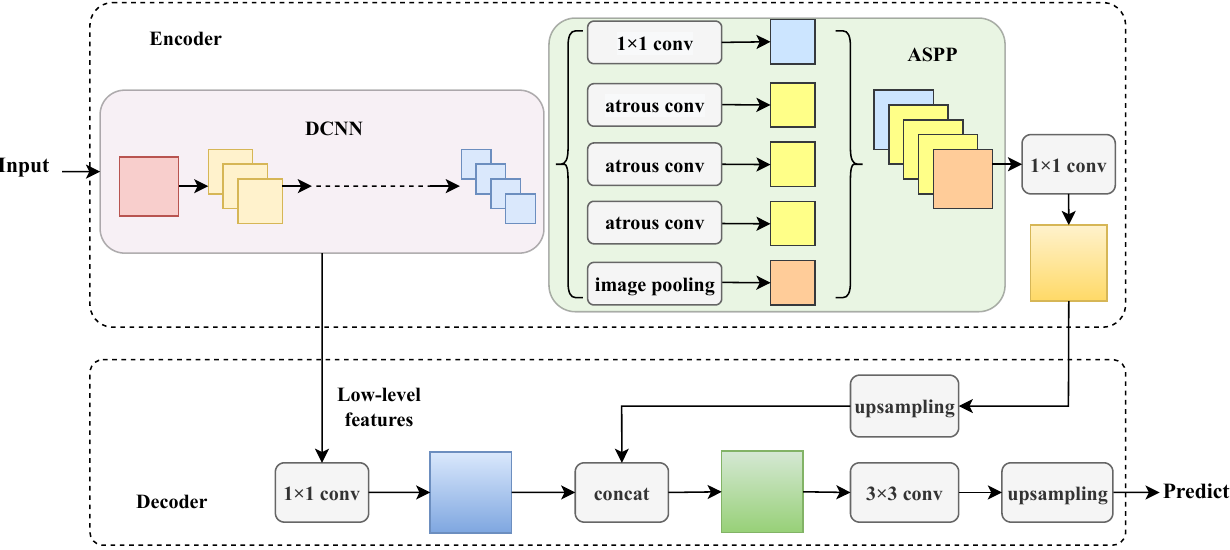
Figure 2. The schematic diagram of